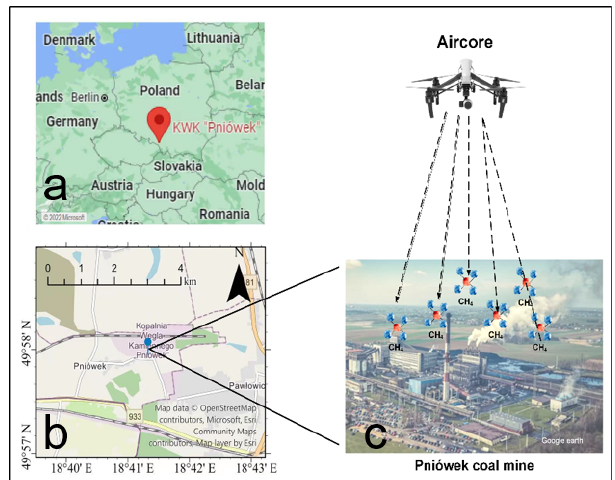
Figure 1. Pniówek coal mine. (a) Red marks represent the loca- tion of Pniówek coal mine in Poland. (b) The surrounding area of Pniówek coal mine; blue marks represent Pniówek coal